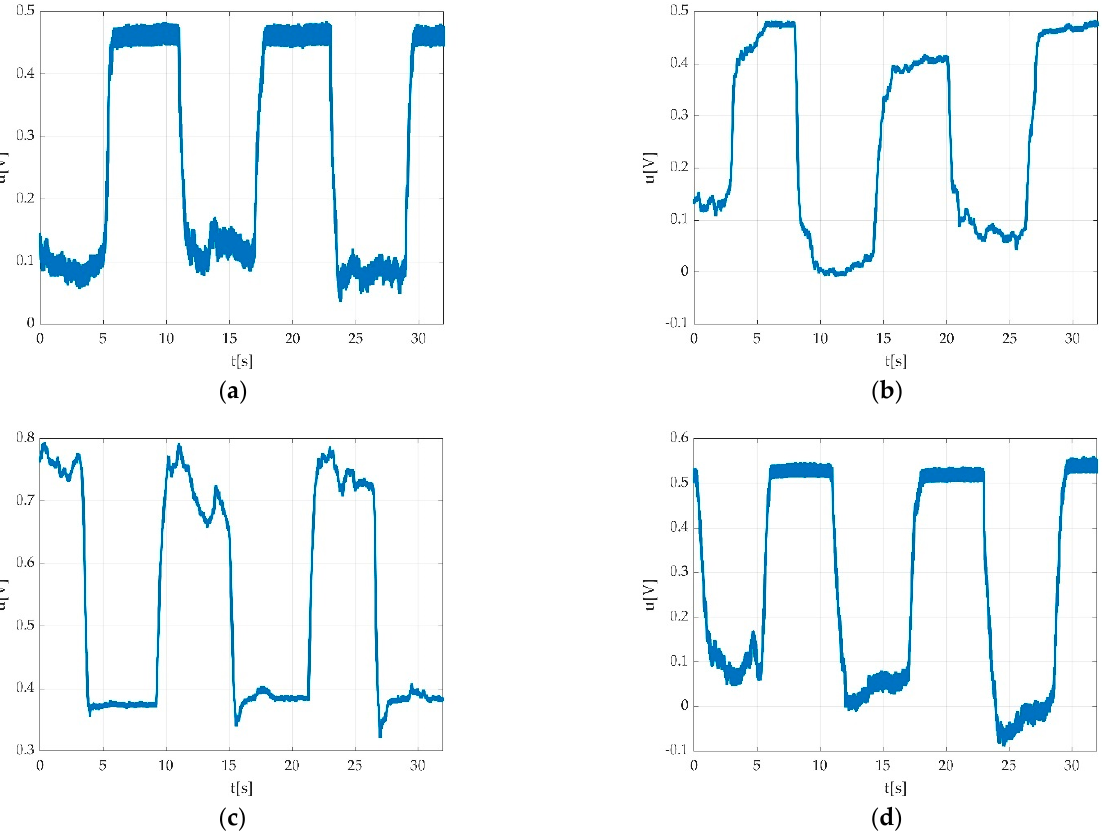
Figure 19. Examples of participant-derived errors; ( a ) good ability to maintain offset level; ( b ) offset unsteadiness due to inability of the participant to control the relaxation period; ( c ) unsteadiness of the offset during breaks between two MVICs; ( d ) inability to maintain the same level of force during MVIC, marked with a red circle.